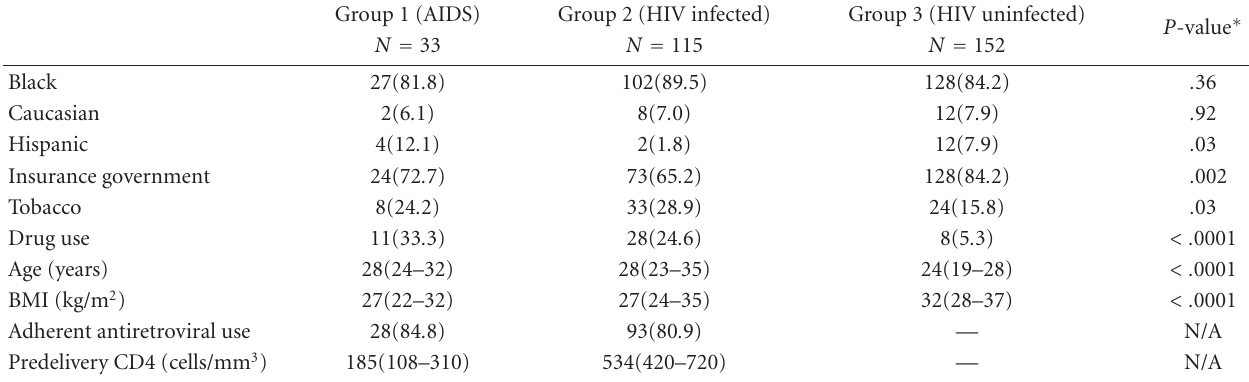
Table 1: Demographic data by group.